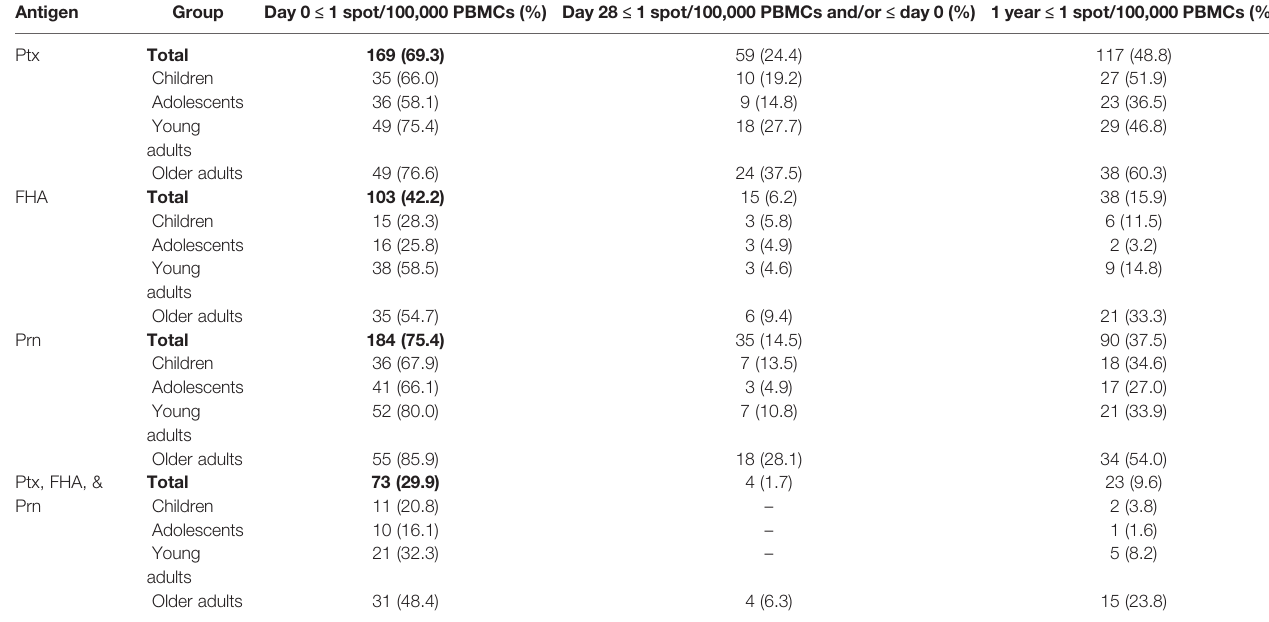
TABLE 3 | Distribution of participants. At day 0 (baseline), the amount of participants with memory B cell frequencies ≤ 1/100,000 PBMCs are shown. Antigen